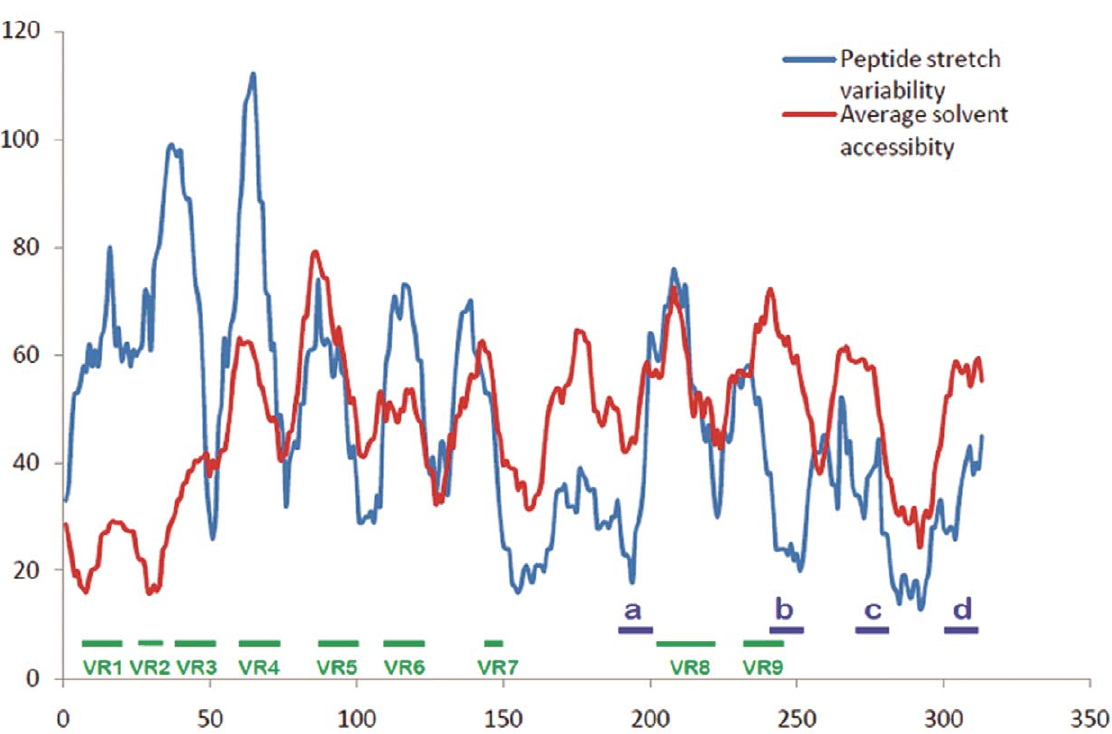
Figure 1. Comparison of solvent accessibility and stretch variability in rotaviral VP7 sequence database. Comparative diagram between solvent accessibility and stretch variability shows the regions of lowest variability and greatest environmentally accessed. All nine variable regions documented from previous research are found clearly distinguishable through our graph. Those regions are marked in green line. Peptide regions (peptide-a, b, c & d) indentified by our method are marked by blue lines.